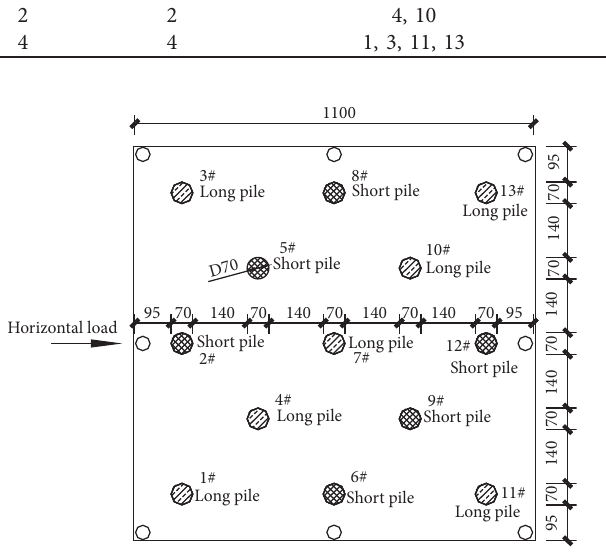
Figure 1: Layout of the piles in the test.